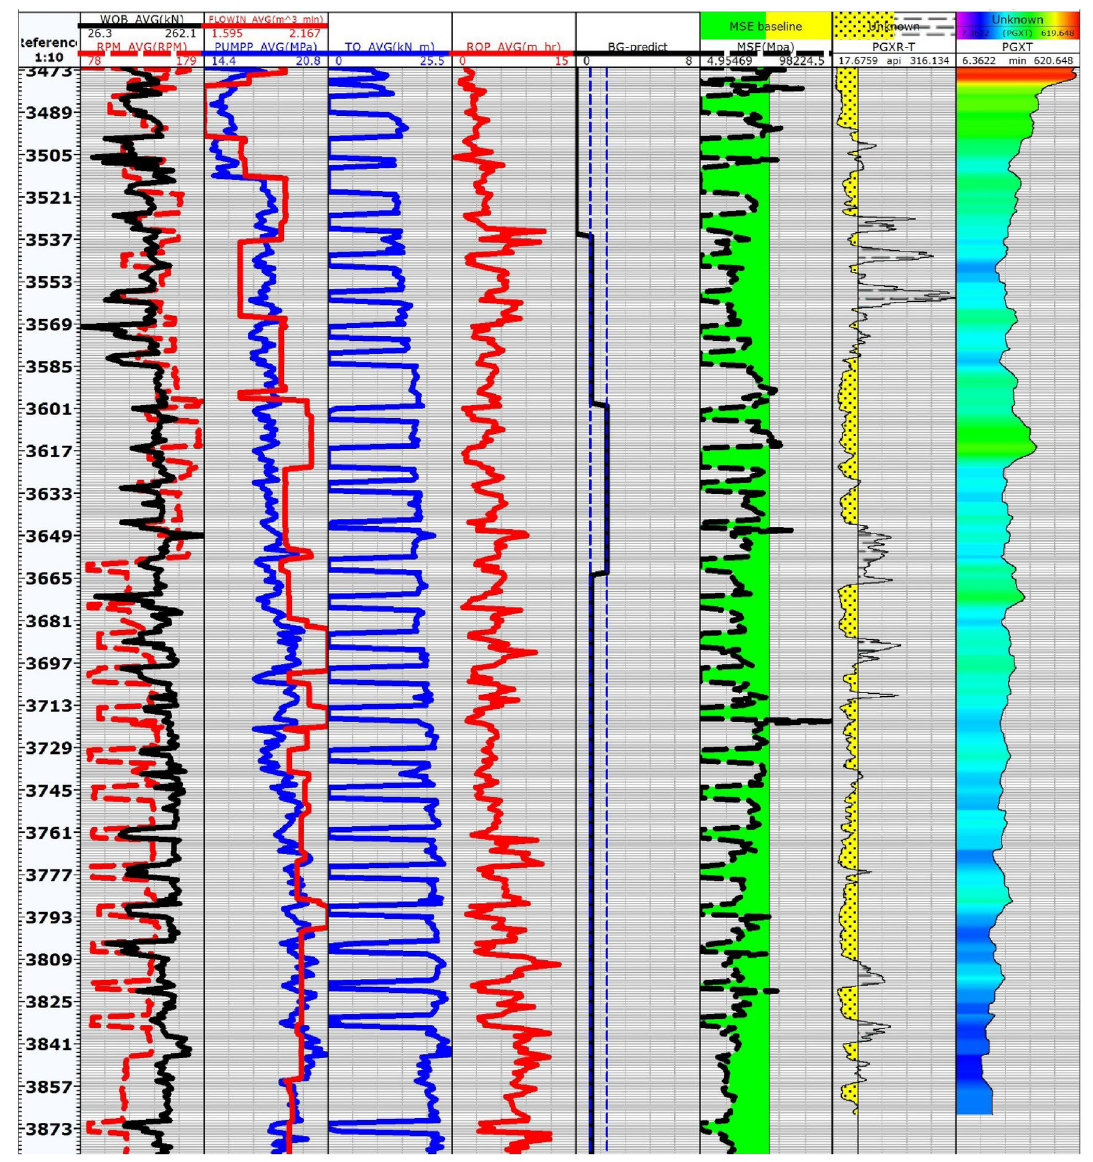
Fig. 6 Wavelet analysis results with PCA component 1 of mud logger dataset in well